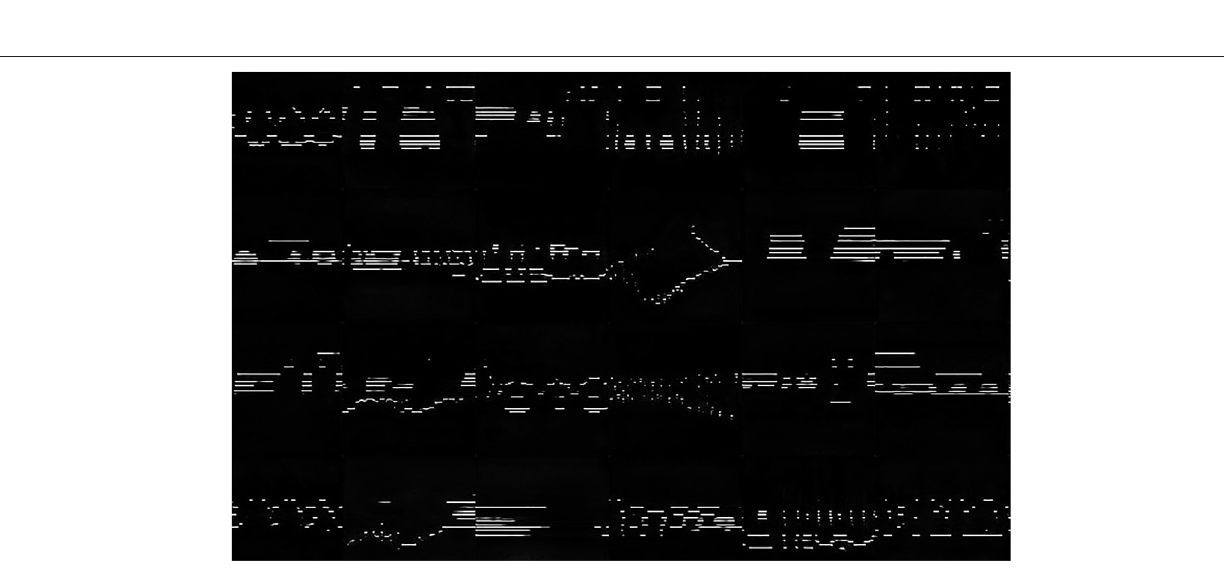
Figure 10F . By interpolation of the latent space, it is also possible to generate a musical progression from one sample to another, with a variable number of intermediate steps, as Figure 10 depicts. For a more musical evaluation, we published a folder. 5 with some selected samples to examine what this approach can potentially generate. There are single samples, which are the direct output of the network translated to MIDI and transformed